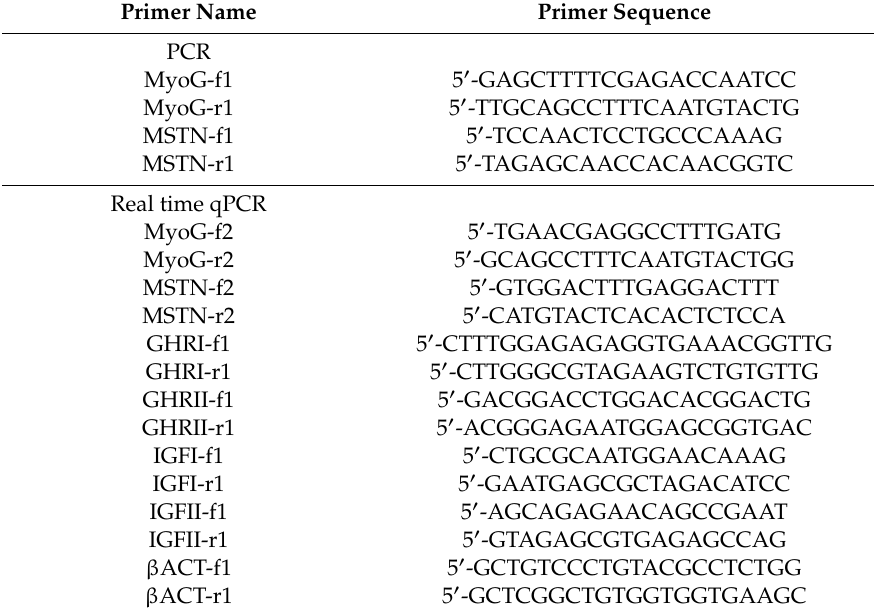
Table 1. Summary of forward (f) and reverse (r) primers used for PCR amplification and real-time qPCR